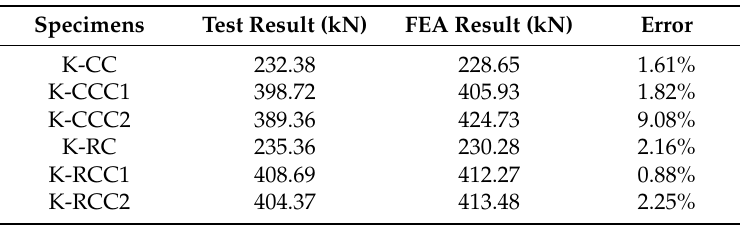
Table 5. The bearing capacity comparison of